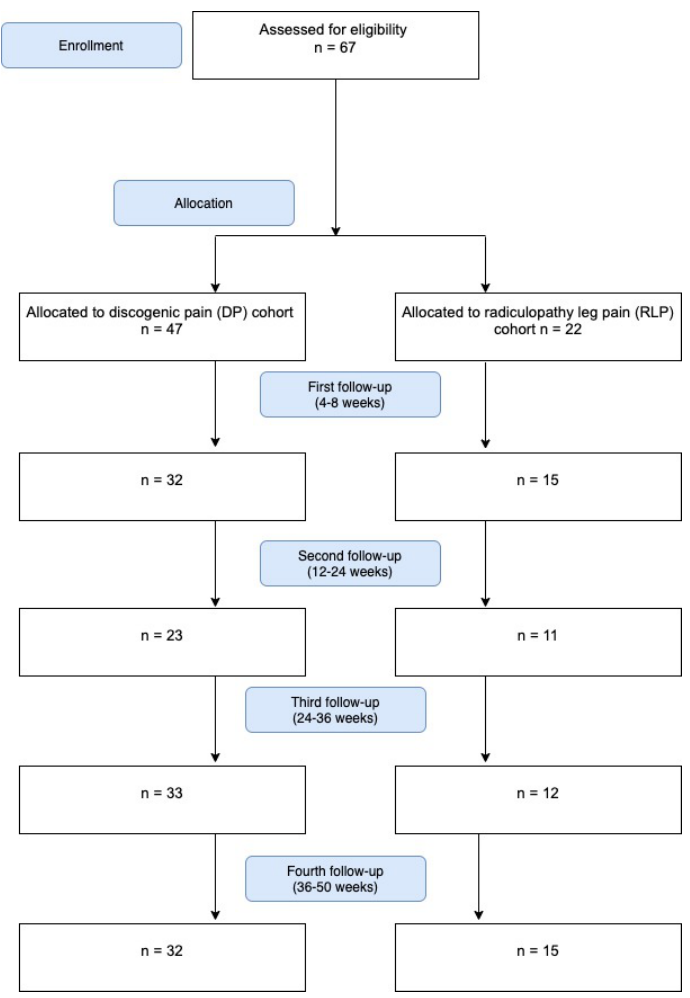
Figure 4. Flow chart of the recruitment and follow-up